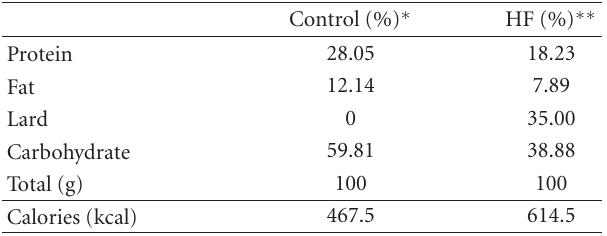
Table 1: Composition of the control and test diets. Table 2: Treatment groups.